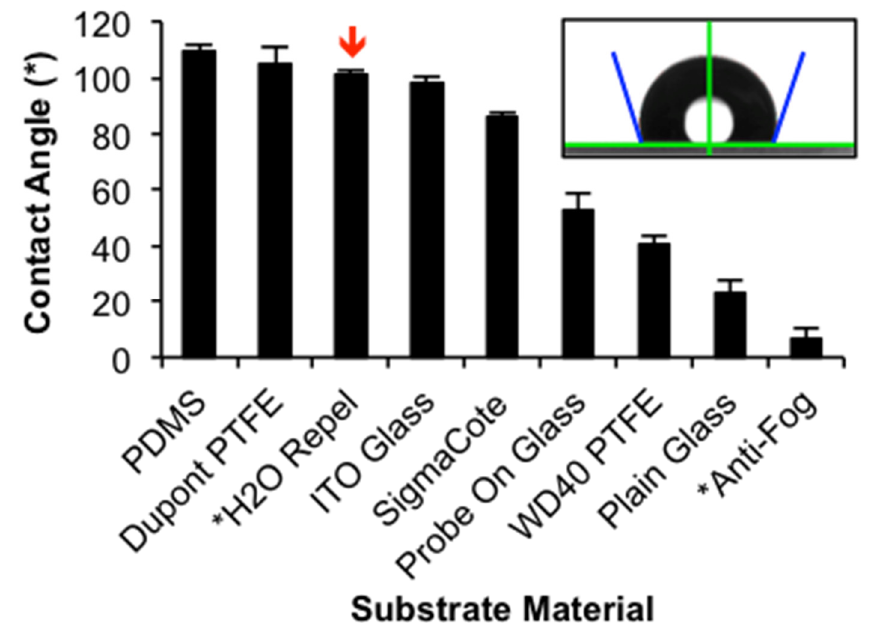
Figure 4. Contact angle measurements, as shown in insert, of 2 μ L MilliQ water droplets on each candidate substrate (mean ± s.d.; n ≥ 13). Coatings with a contact angle less than 85° did not centrally deposit particles during evaporation. Red downward arrow indicates substrate selected for final design (H2O Repel). * Indicates Rain-X ® product.